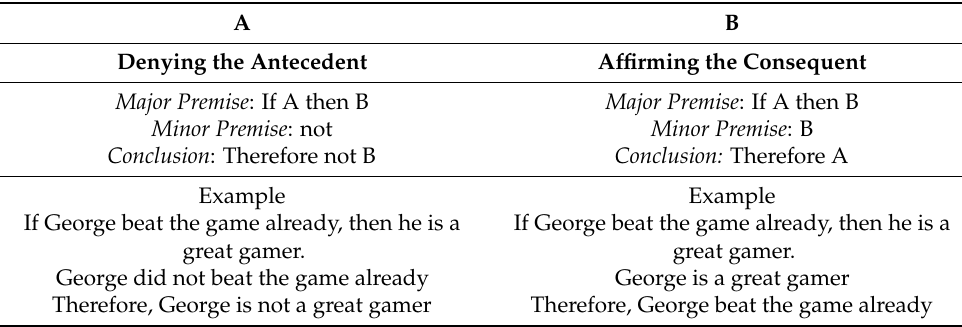
Table 2. Example of Aristotle Invalid